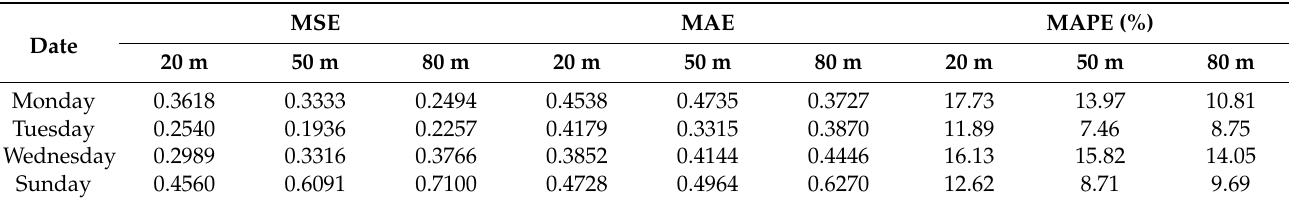
Figure 7. The bar chart for the evaluation index of the Elman neural network. Table 3. The evaluation index of